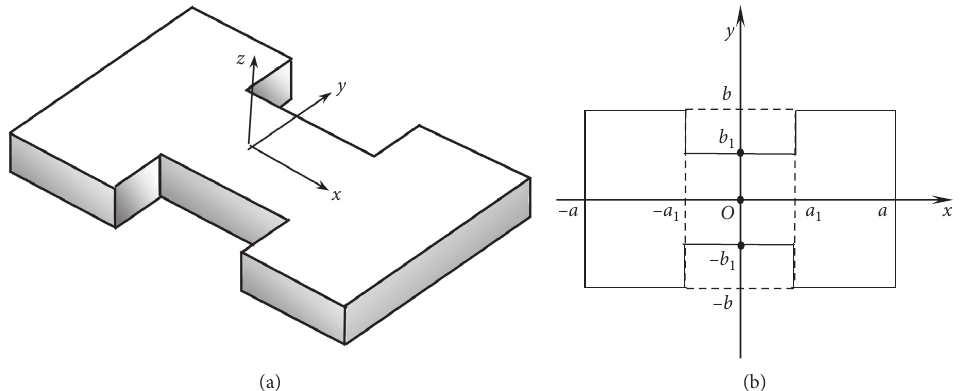
Figure 1: Planform of the composite plate with rectangular cuts.